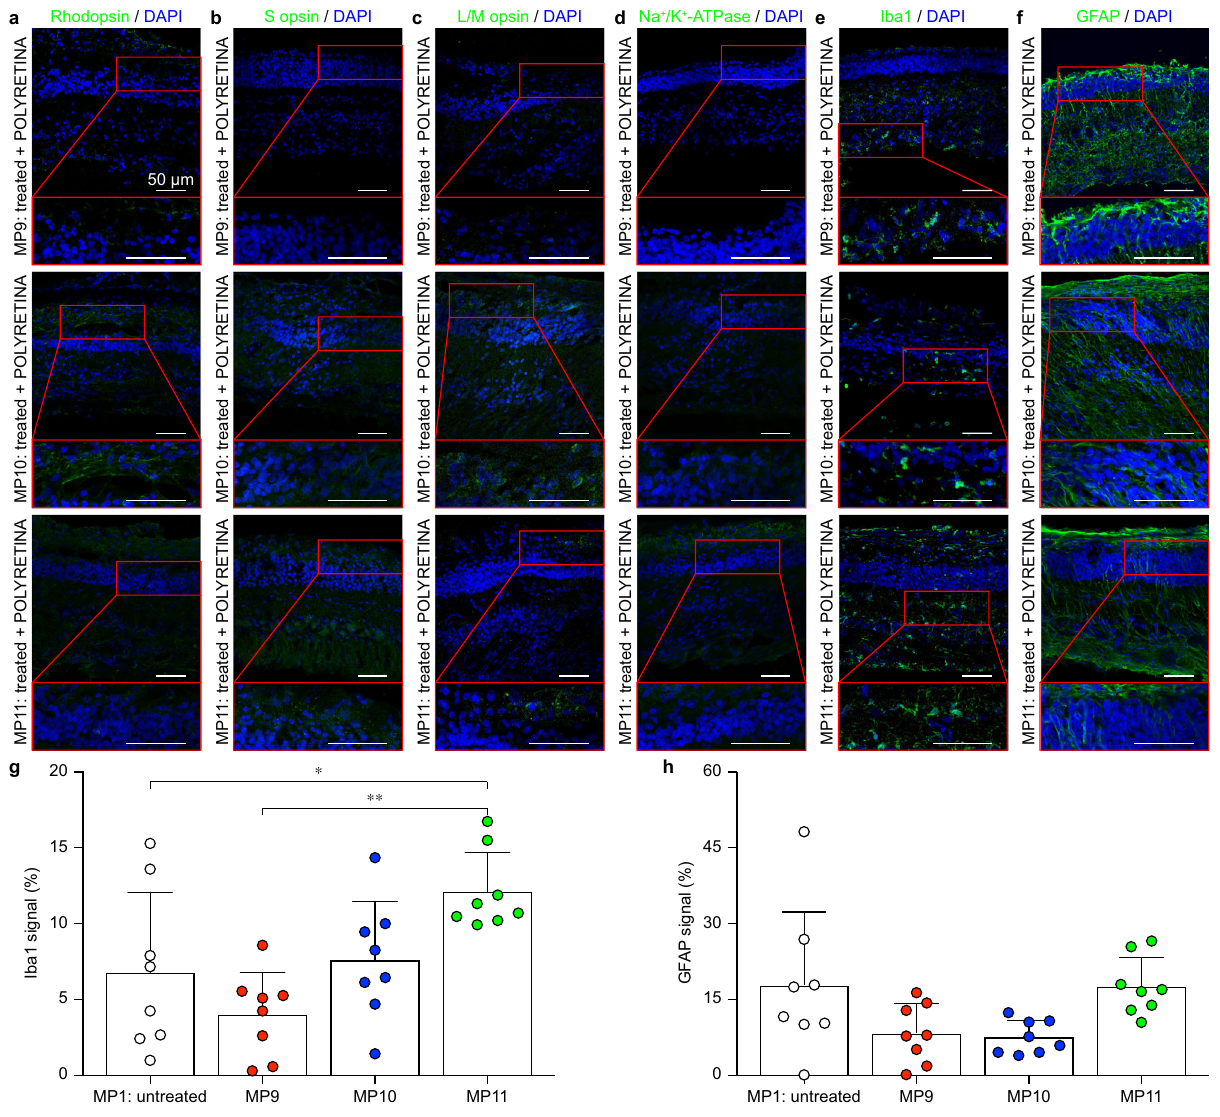
Fig. 8 Histological assessment of implanted blind minipigs. a – f IHC staining against rhodopsin ( a ), S opsin ( b ), L/M opsin ( c ), Na + /K + -ATPase ( d ), Iba1 ( e ) and GFAP ( f ) 2 weeks after POLYRETINA implantation. Each row corresponds to one implanted minipig. The red inserts show magni fi cations of the retinal sections. All scale bars in panels a – f are 50 µ m. g Quanti fi cation of the expression level for Iba1 in the three implanted minipigs and one untreated minipig (mean ± s.d., n = 8 points from 1 eye for each minipig). One-way ANOVA: p = 0.0022 and F = 6.263; Tukey ’ s multiple comparisons test: MP1 vs MP9 p = 0.4756, MP1 vs MP10 p = 0.9732, MP1 vs MP11 p = 0.0422 (*), MP9 vs MP10 p = 0.2569, MP9 vs MP11 p = 0.0011 (**), MP10 vs MP11 p = 0.1048. h Quanti fi cation of the expression level for GFAP in the three implanted minipigs and one untreated minipig (mean ± s.d., n = 8 points from 1 eye for each minipig). One-way ANOVA: p = 0.0271 and F = 3.548; Tukey ’ s multiple comparisons test: MP1 vs MP9 p = 0.1374, MP1 vs MP10 p = 0.0967, MP1 vs MP11 p > 0.9999, MP9 vs MP10 p = 0.9979, MP9 vs MP11 p = 0.1513, MP10 vs MP11 p = 0.1071). In g and h , for each minipig, data from images at eight locations have been averaged, corresponding to the peripheral nasal retina, the central nasal retina, the central temporal retina, and the peripheral temporal retina at the level of either the area centralis of the optic disc. Images in panels a – f are from MP9 – 11. Data in panels g , h are from MP1,9 – 11. Source data are provided as a Source Data fi